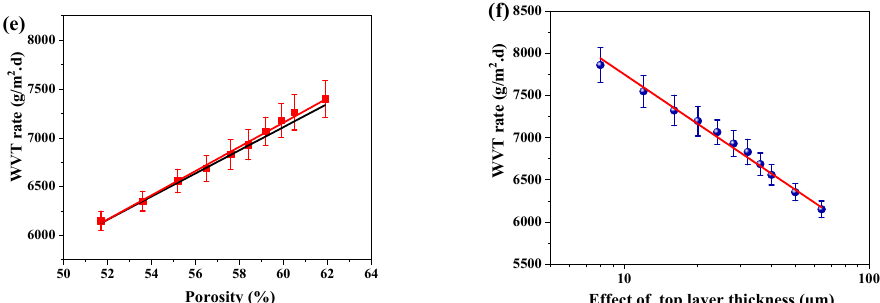
Figure 7. ( a ) air permeability and ( b ) WVT rate of a micro/-nano-composite membrane in relation to different TPU thicknesses; the linear relationship of PLA-PU-16 between ( c ) air permeability and porosity, ( d ) air permeability and pressure drop, ( e ) WVT rate and porosity, ( f ) WVT rate and thick- ness.